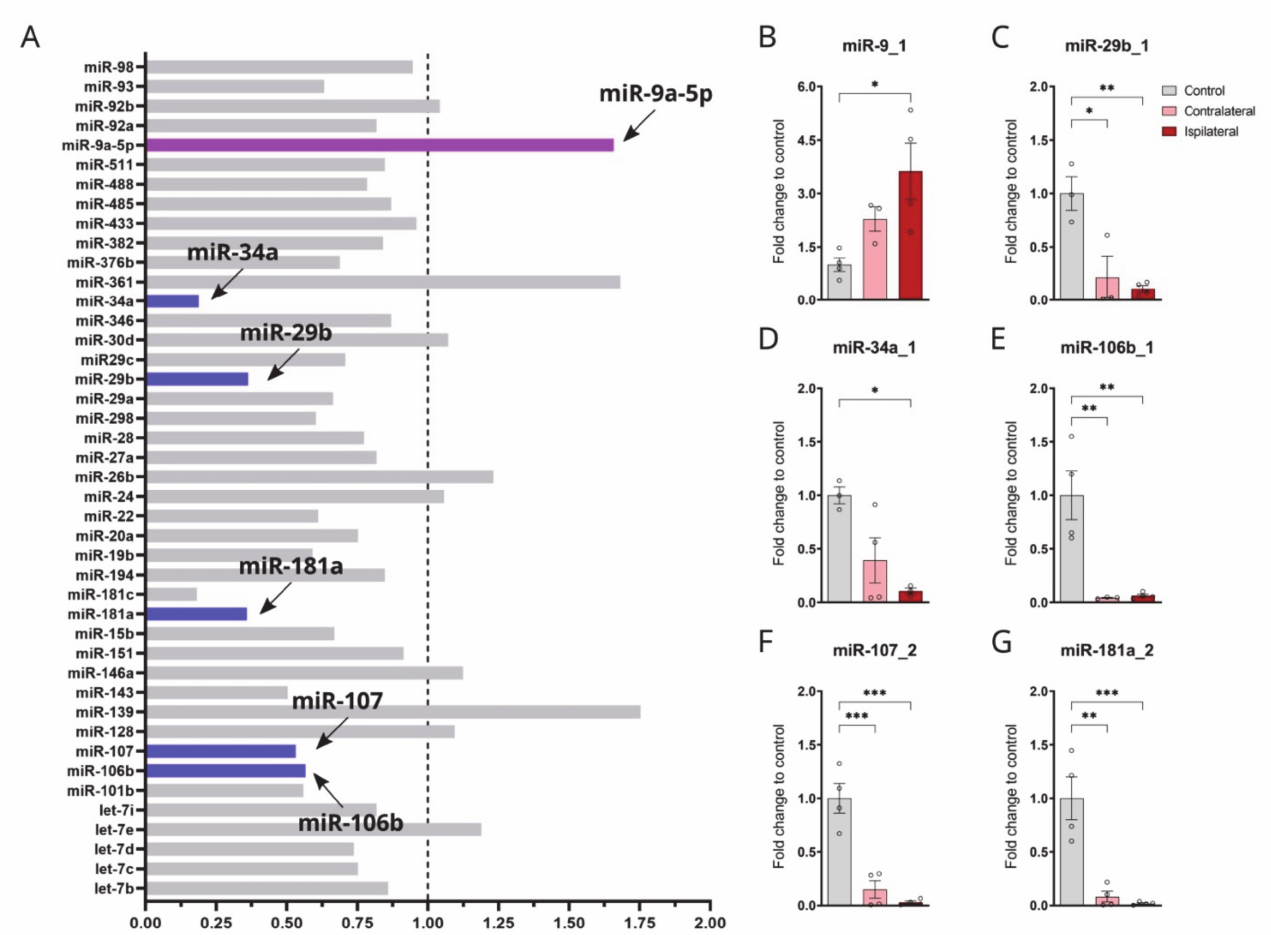
Figure 1. TBI alters the expression of miRNAs involved in neurological disorders. ( A ) Results ob- tained from miScript miRNA PCR array focused on miRNAs involved in neurological development and disease, comparing samples obtained in the ipsilateral hemisphere with the contralateral hemi- sphere in a rat model of CCI. Due to the large cohort of data, only those miRNAs that showed a fold change larger than +/ − 0.2 were included in the graph. ( B – G ) Quantification of miRNA expression analysis by qPCR from rat CCI brain (ipsilateral and contralateral sides) and naïve rats (n = 4 per group). ( B ) quantification of miR-9_1 (one-way ANOVA F = 6.390 p = 0.0220); ( C ) miR-29_1 (one-way ANOVA F = 13.54 p = 0.0039); ( D ) miR-34a_1 (one-way ANOVA F = 7.614 p = 0.0175); ( E ) miR-106b_1 (one-way ANOVA F = 15.07 p = 0.0019); ( F ) miR-107_2 (one-way ANOVA F = 32.48 p < 0.0001); ( G ) miR-181a_2 (one-way ANOVA F = 21.50 p = 0.0004). Columns represent mean ± SEM,